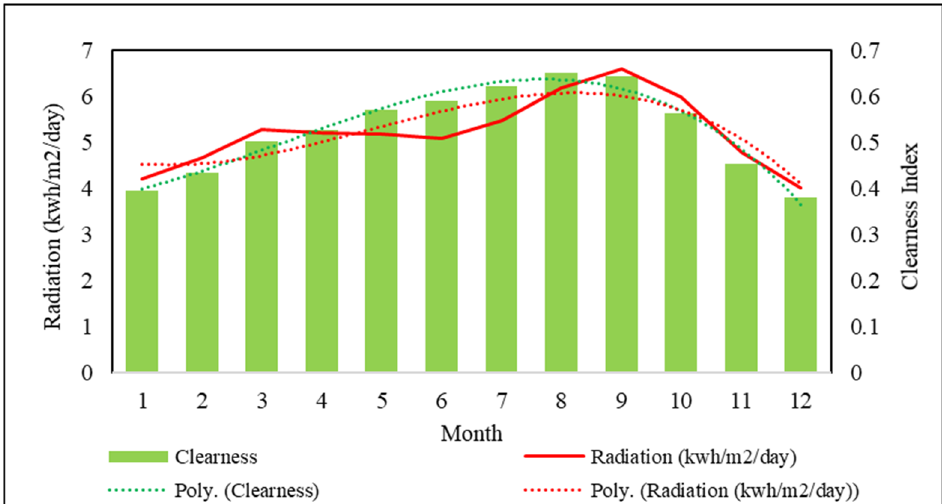
Figure 10. Daily characteristic irradiation on Karimunjawa Island.